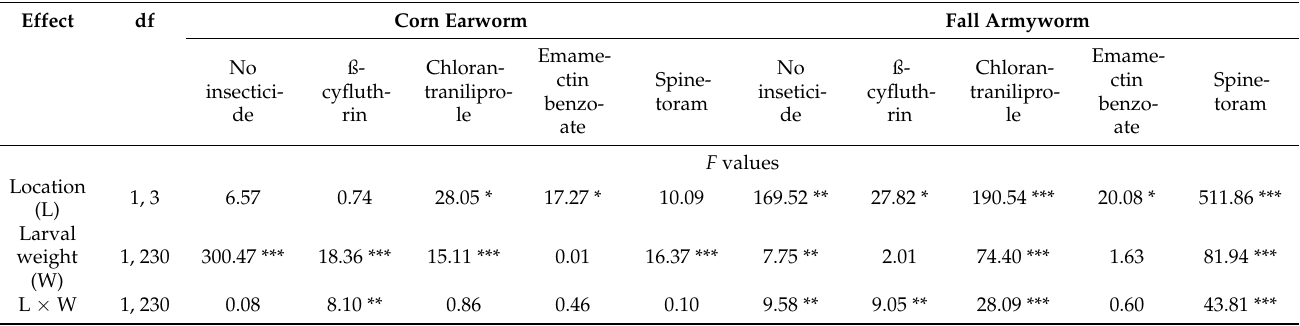
Table 5. Combined analysis of variance for the location and weight of corn earworm ( Helicoverpa zea (Boddie) (Lepidoptera: Noctuidae)) and fall armyworm ( Spodoptera frugiperda (J. E. Smith) (Lepi- doptera: Noctuidae)) larvae evaluated at 96 h after insecticide application in 2019 and 2020.